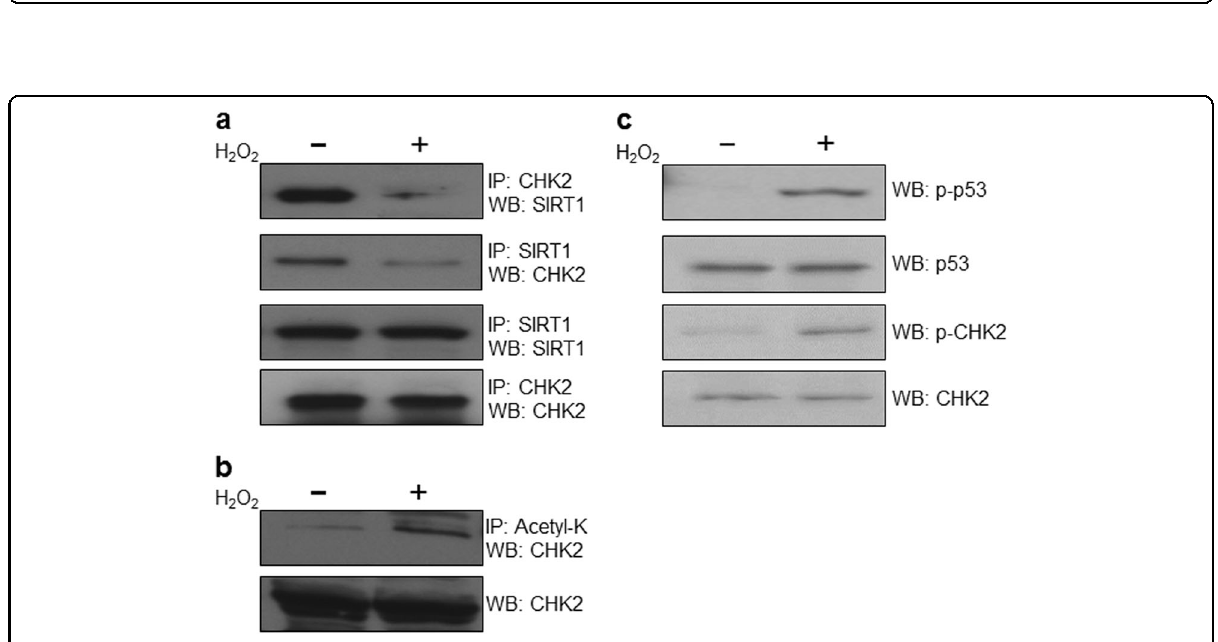
Fig. 2 SIRT1 dissociates with CHK2 for its activation upon oxidative stress. a SIRT1 bound CHK2 under control conditions but dissociated with CHK2 after treatment with 1 mM of H 2 O 2 in HeLa cells. b The acetylated CHK2 level was elevated in response to oxidative stress in HeLa cells. c DDR pathways were activated upon oxidative stress. The phosphorylation levels of CHK2 (p-CHK2) and p53 (p-p53) were highly increased in response to oxidative stress in HCT116 cells. IP immunoprecipitation, WB Western blot. Western blots in fi gures are representative of more than three independent